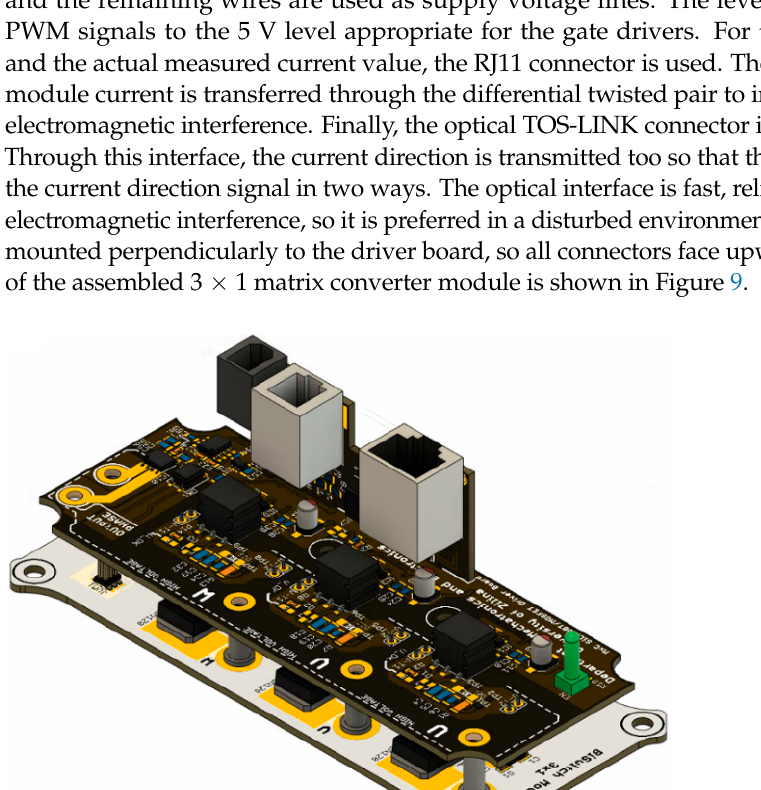
Figure 9. Assembled model of 3 × 1 matrix module